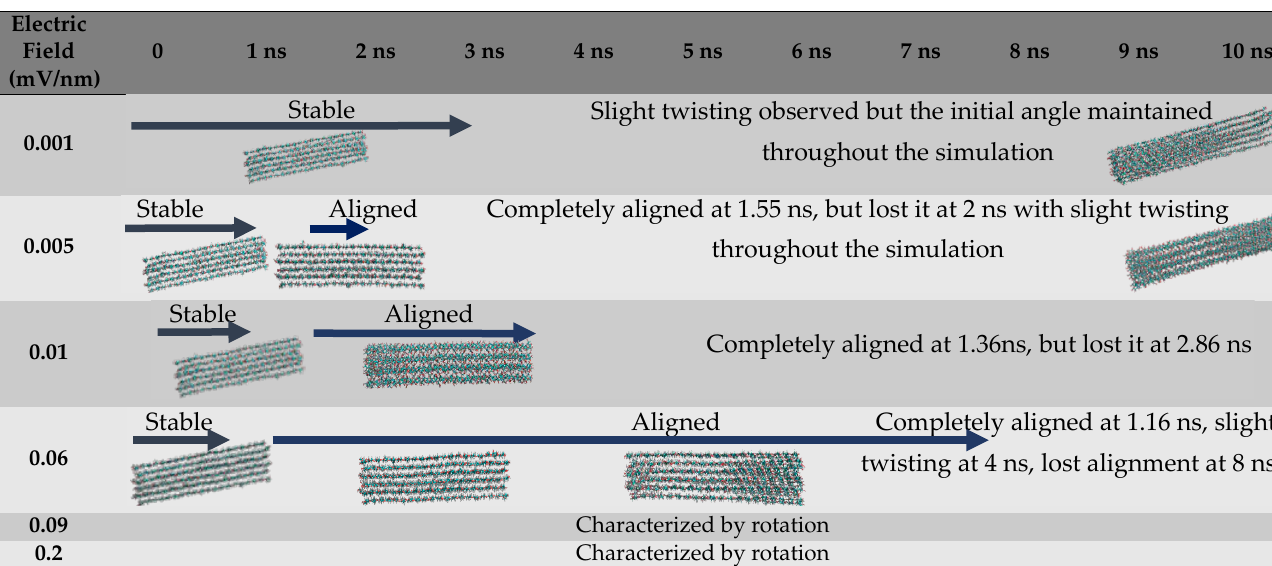
Table 1. Snapshots of CNF alignment along with the applied external electric fields (z‐axis).